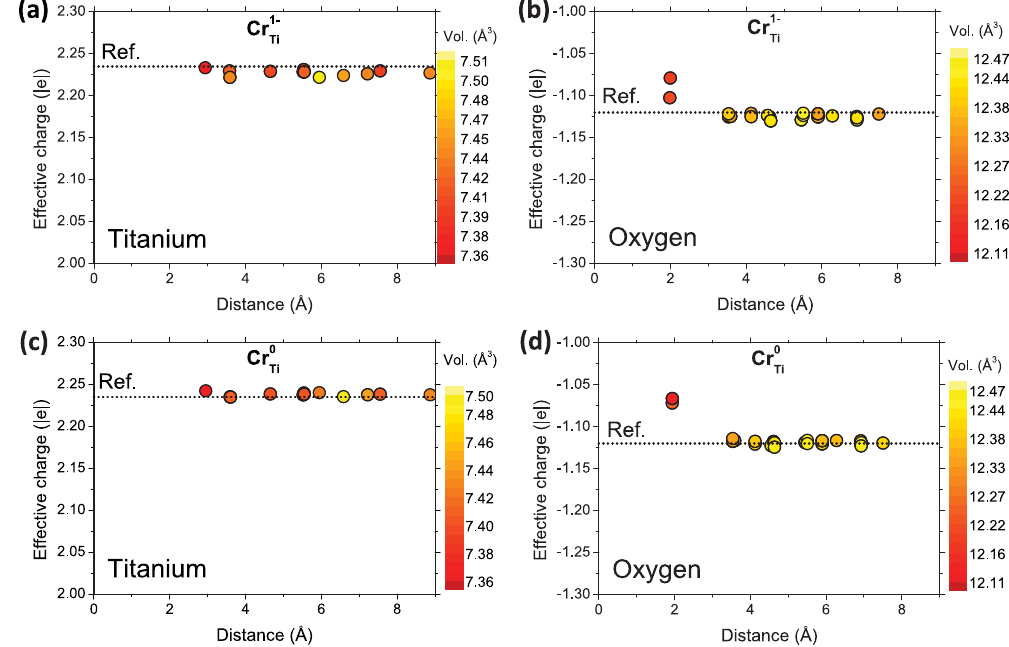
Figure 1. Bader effective charge as a function of the distance from the Cr defect for ( a ) Titanium atoms and ( b ) Oxygen atoms in Cr Ti1 − defect, and ( c ) Titanium atoms and ( d ) Oxygen atoms in Cr Ti0 . Dotted line represents the Bader charge for bulk rutile.